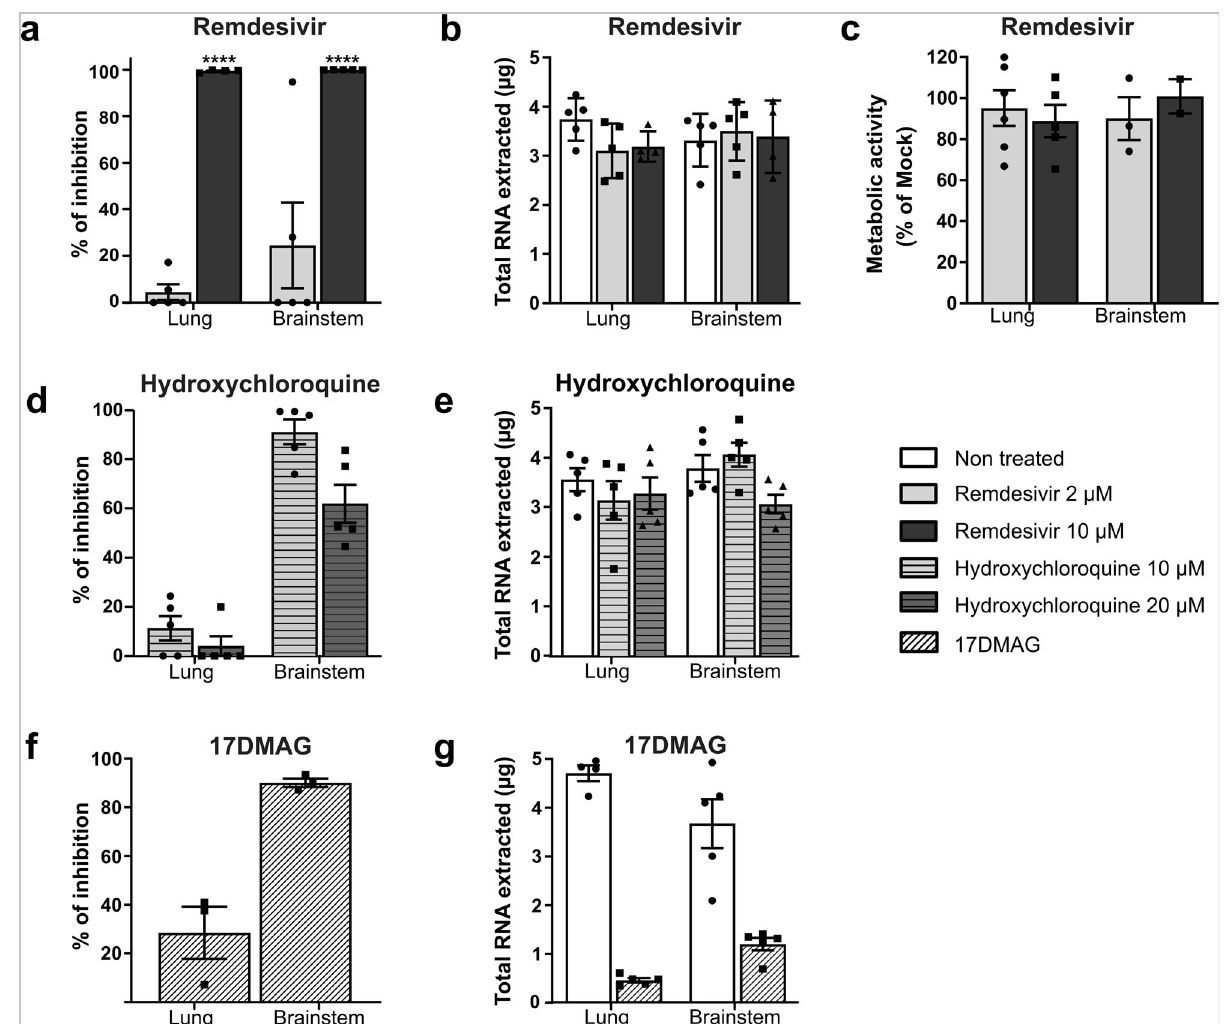
Fig. 3 Antiviral activity of remdesivir, hydroxychloroquine, and 17-DMAG in hamster organotypic cultures infected by SARS-CoV-2. a , d , f Organotypic cultures from hamsters were infected with SARS-CoV-2 at 1000 pfu/slice and treated at the indicated concentrations of remdesivir, hydroxychloroquine, and 17-DMAG at 90 min, 24, 48, and 72 h after infection ( n = 5 biologically independent animals). Total RNA was harvested at 4 days post infection and the number of SARS-CoV-2 genomes was quanti fi ed by RT-qPCR. Results are expressed in % of inhibition of the infection compared with non-treated cultures. Statistical analyses were performed using the Kruskal – Wallis test. * P < 0.05; ** P < 0.01; *** P < 0.001. b , e , g Total RNA extracted per organotypic culture was quanti fi ed. c The toxicity of remdesivir on uninfected cultures that were treated in the same way was assessed via the Alamar blue assay. Results are expressed as the percentage of metabolic activity after 4 days compared with the non-treated samples. All error bars represent SD. Source data are provided as a Source Data fi